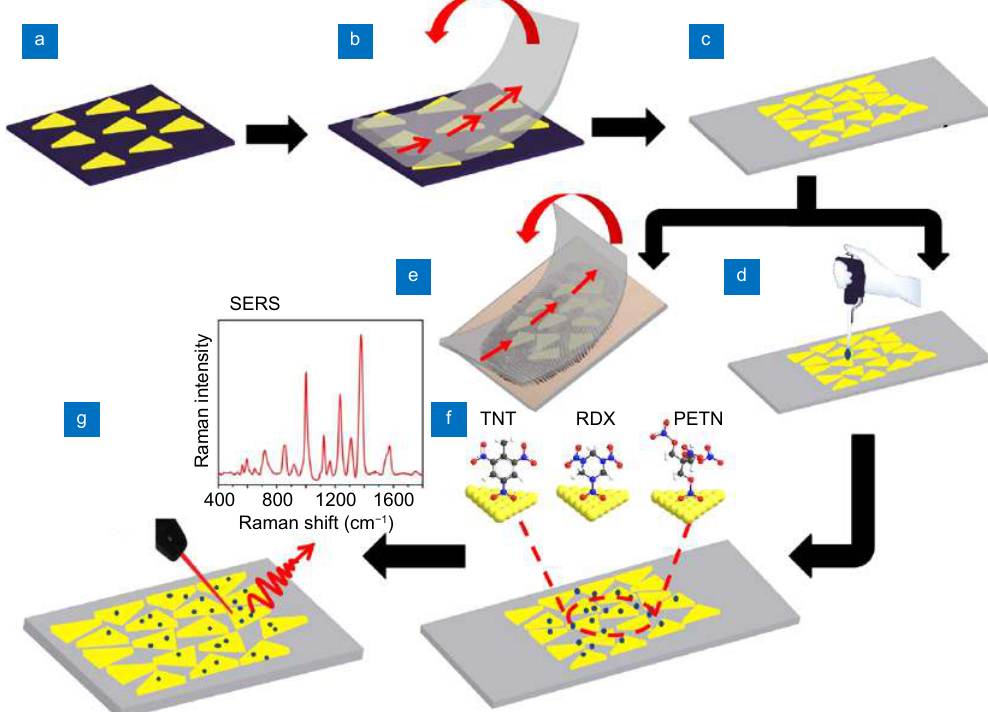
Fig. 4 | Explosive trace detection using flexible SERS substrates detection of TNT, RDX, and PETN using self-assembly triangular nan- oprisms on adhesive tape. Figure reproduced with permission from ref. 58 , Royal Society of